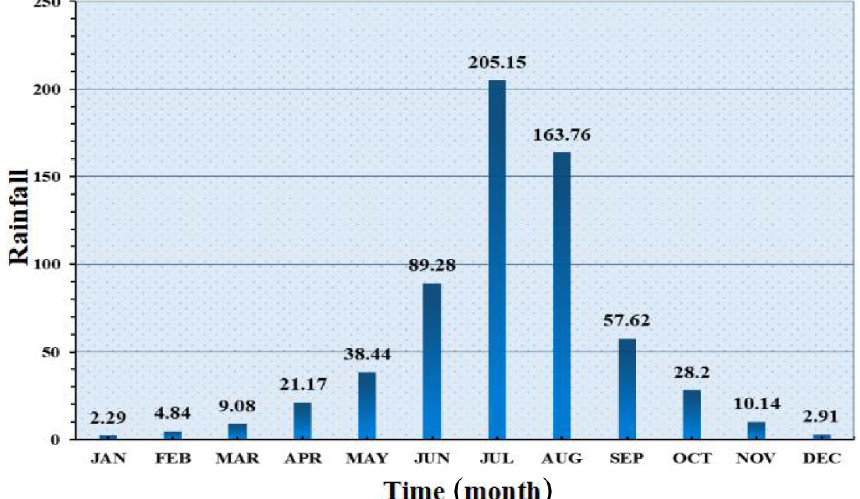
Figure 1. Average monthly rainfall data (from 1959 to 2017) for Pinggu